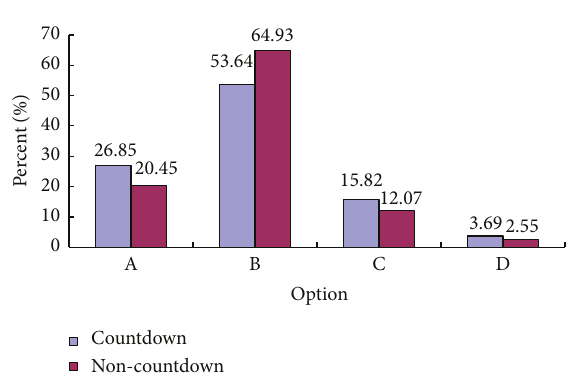
Figure 1: Comparison of driving behaviors before the end of the green light at two types of